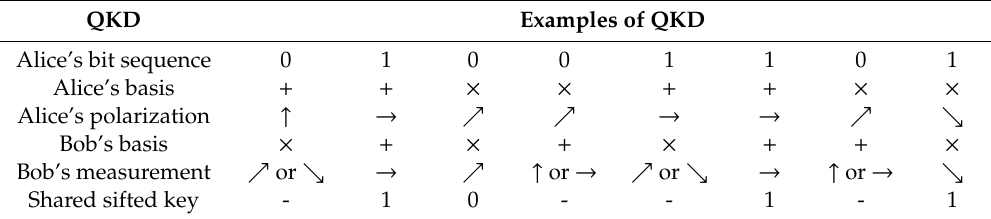
Figure 1. Quantum key distribution (QKD) based on polarization encoding. Table 1. Quantum key generation based on the BB84 Protocol.